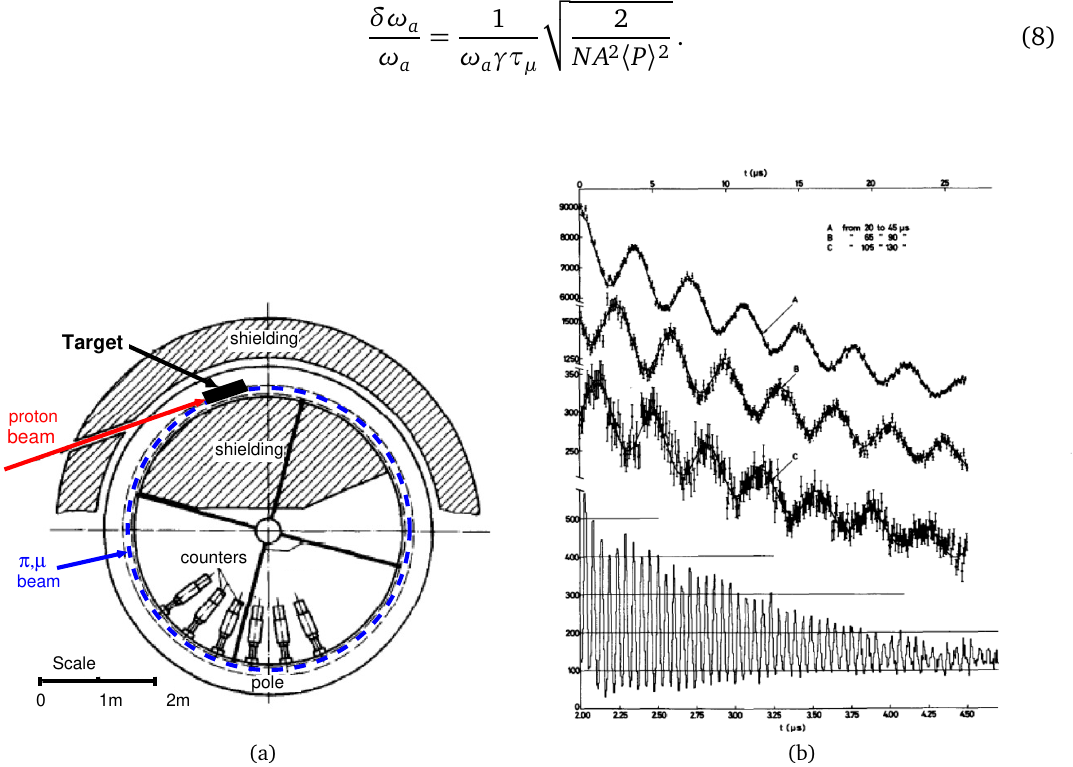
Figure 5: (a)The arrangement of the first CERN storage ring, showing the enter- ing proton beam, the location of the shielding and detectors. There were four NMR probes (not shown) that were periodically inserted into the storage region to mea- sure the magnetic field. (From Ref. [ 34 ] but re-labeled for clarity.) (b) The arrival time spectrum of high-energy positrons from the CERN-2 experiment. The rapid os- cillations in the bottom of the figure are from the cyclotron frequency of the muon bunch, which dies out after 400 µ s. The time spectrum is folded back on itself, where A is from 20-45 µ s, B from 65-90 µ s, C from 105-130 µ s. (From Ref. [ 34 ] ). The result obtained in CERN-2 was